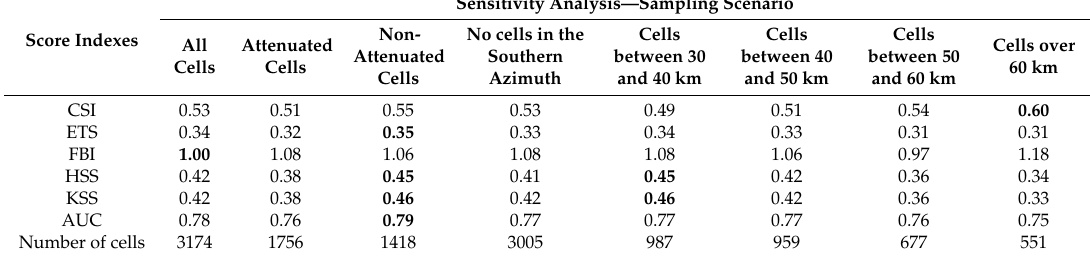
Table 7. Statistical scores for QDA-based criterion obtained with respect to eight different sampling scenarios. The first one (“All cells”) refers to the entire test dataset of convective cells. The others allow evaluating the sensitivity of the multi-parameter algorithm to the impact of some potential issues (details are provided in the text). Bold numbers indicate the scenario showing the best results for the five different score